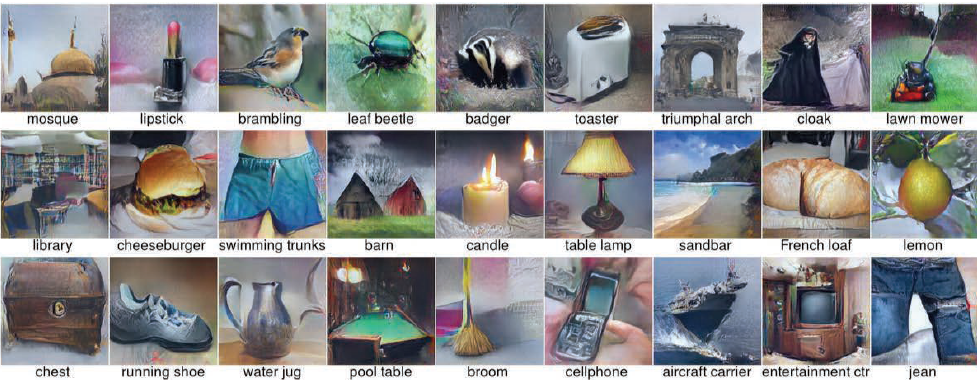
Figure 9. To explain what a black box classifier network comprehends as a class member [58] to make synthetic prototype images that look real. They were created by a deep generator network and classified by the black box neural